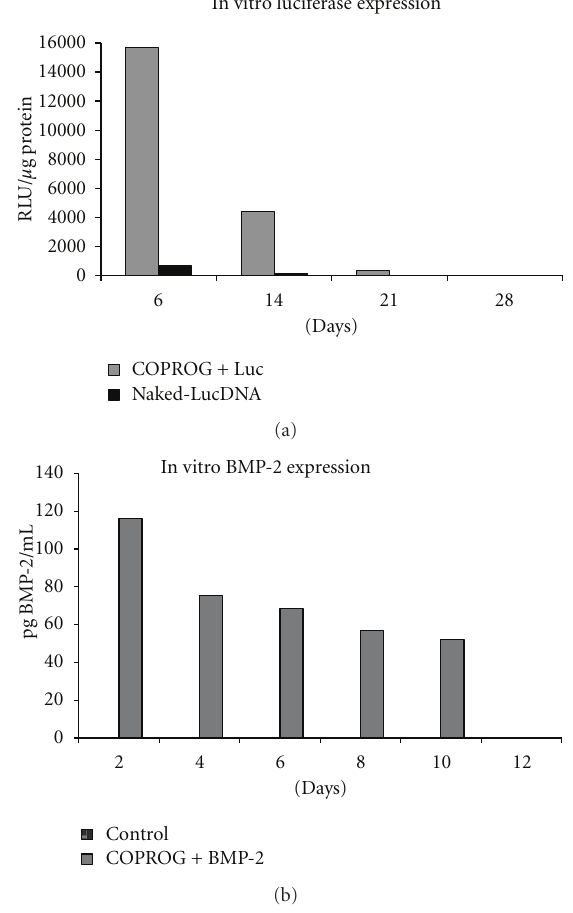
Figure 1: (a) In vitro luciferase expression of the COPROG + luciferase versus naked-luciferase DNA group. (b) In vitro BMP-2 expression of the COPROG + BMP-2 plasmid versus the control group (copolymer without